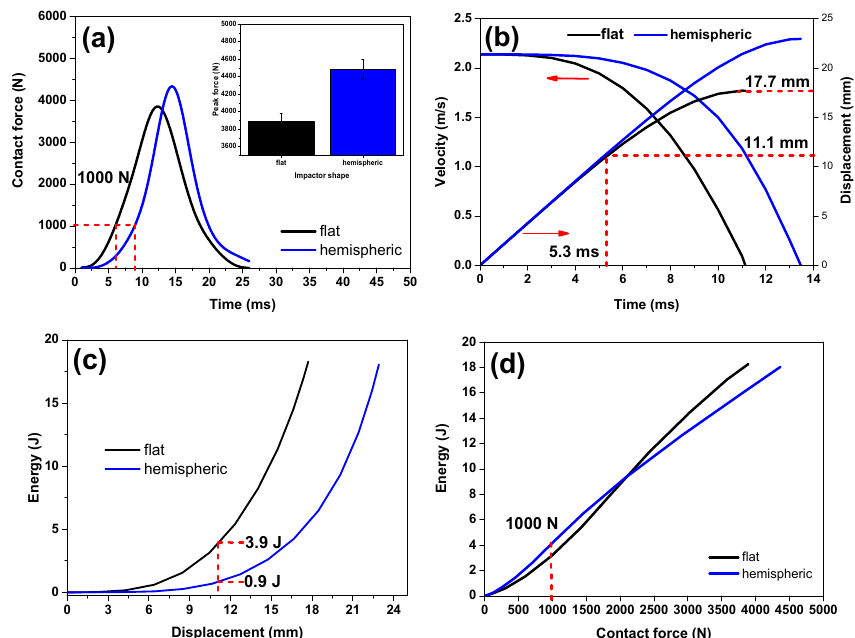
Figure 11. ( a ) Contact force–time curves of bionic composite with 1 wt% EV impacted with different impactors; ( b ) Velocity–displacement curves; ( c ) Displacement–energy absorption curves; ( d ) Contact force–energy absorption curves.